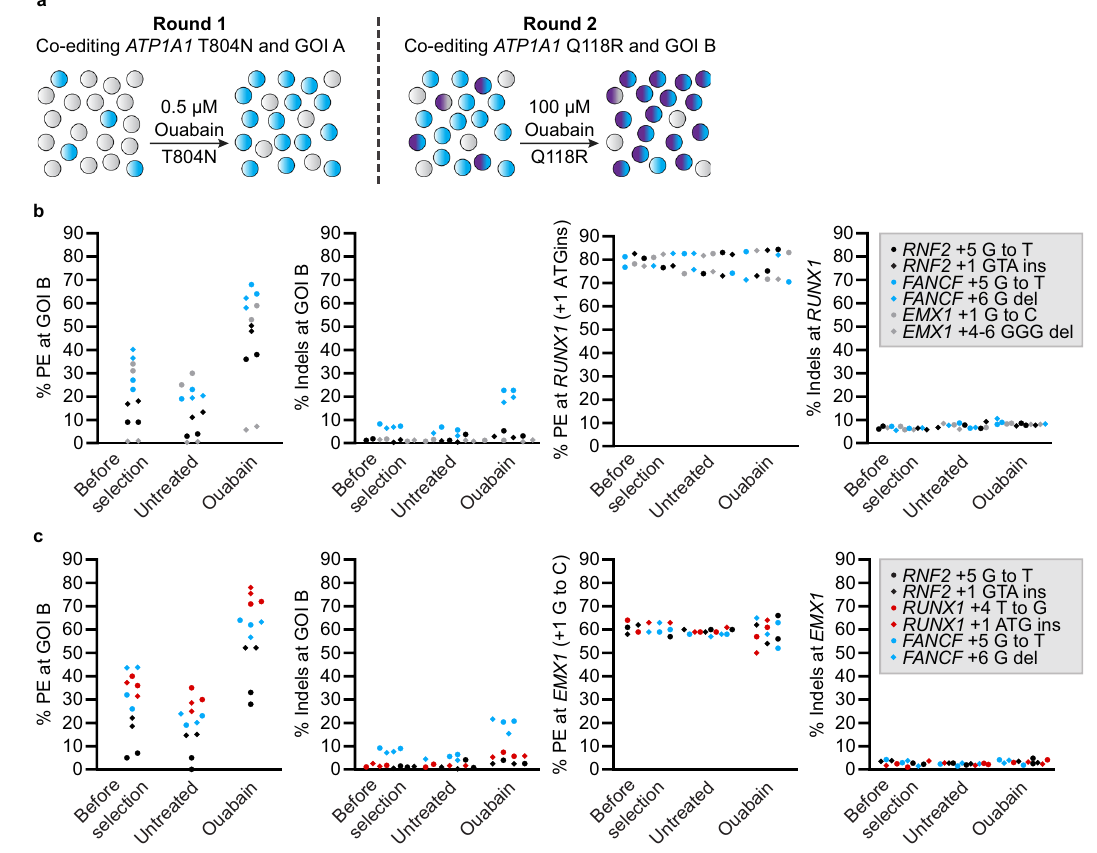
Fig. 2 | Robust co-selection for successive roundsofprimeediting. a Schematic of the strategy for performing successive rounds of co-selection. Cells harboring modi fi cations at ATP1A1 (T804N) and GOI A are fi rst co-selected with 0.5 µ M oua- bain.Following the fi rstround,asubsequent round of co-selectionoccursatGOI B via modi fi cation at ATP1A1 (Q118R) with 100 µ M ouabain. b PE and small indels quanti fi cation as determined by BEAT and TIDE analysis from Sanger sequencing. K562 cells harboring the ATP1A1 -T804N and RUNX1 +1 ATG insertion (GOI A)